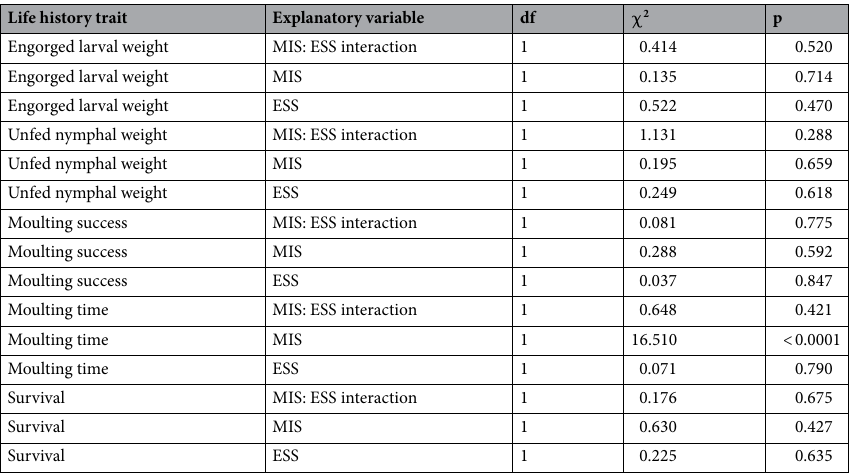
Table 1. Statistical analyses of the five life history traits of the immature I. ricinus ticks. The five life history traits include engorged larval weight, unfed nymphal weight, larva-to-nymph moulting success, larva-to- nymph moulting time, and immature tick survival. LMMs and GLMMs were used to test the effects of mouse infection status (MIS), egg surface sterilization (ESS), and their interaction (MIS: ESS) on the five life history traits. Shown are the results from the type II log-likelihood ratio test to determine the statistical significance of the explanatory variables. The row headers refer to the life history trait, the explanatory variable, the degrees of freedom (df), the Chi-square statistic ( χ 2 ), and the p-value (p).